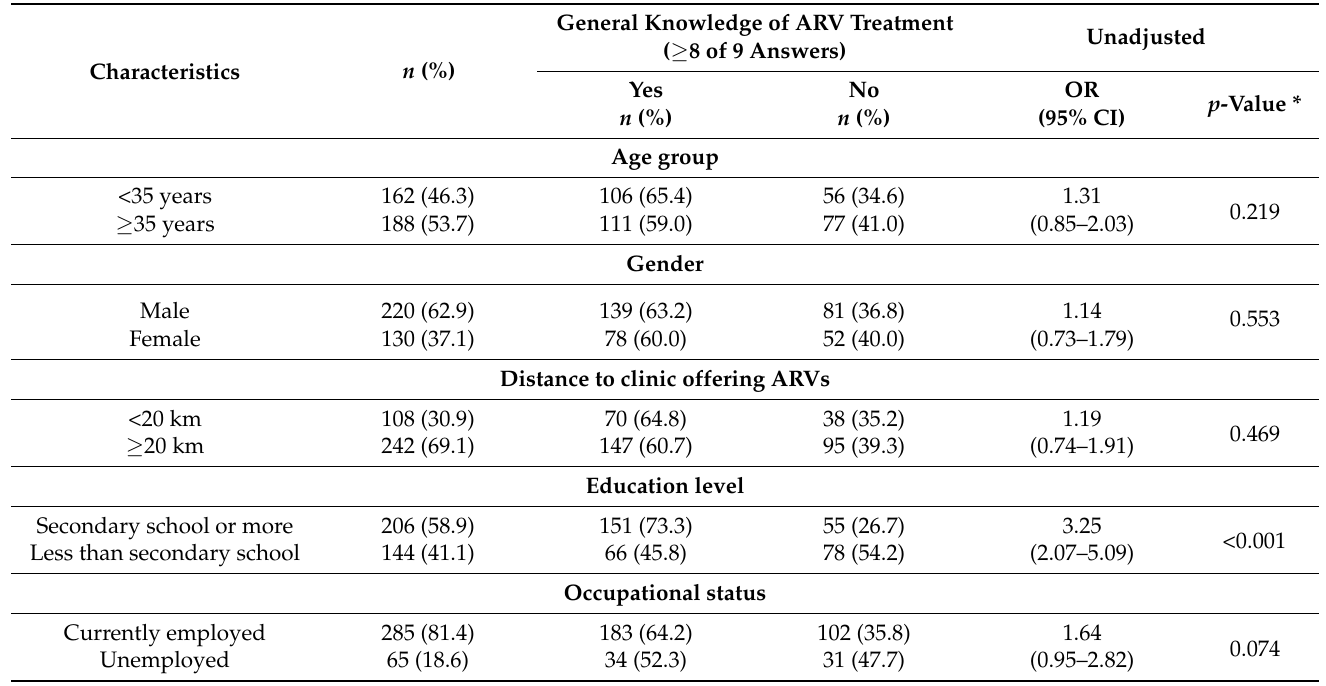
Characteristics